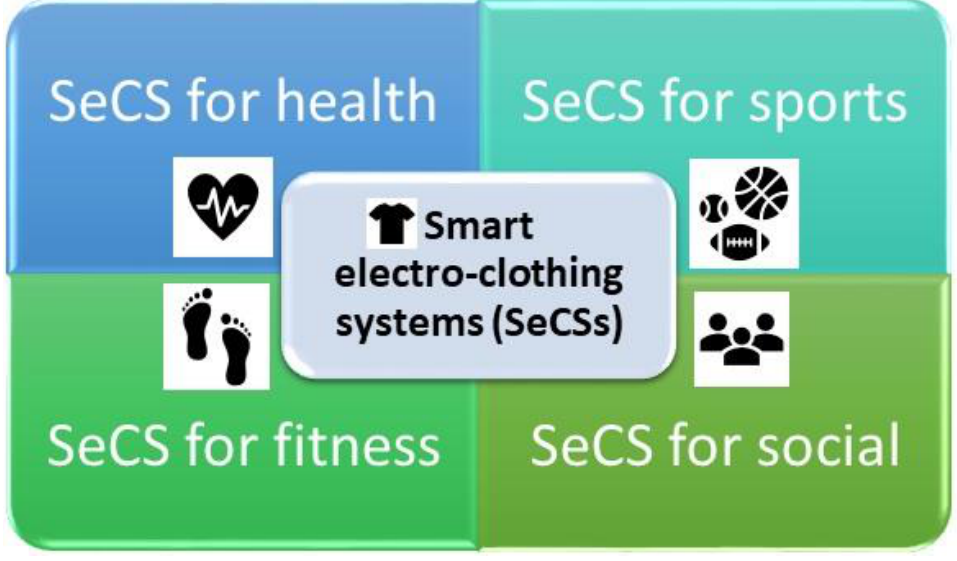
Figure 2. Classification of SeCSs.